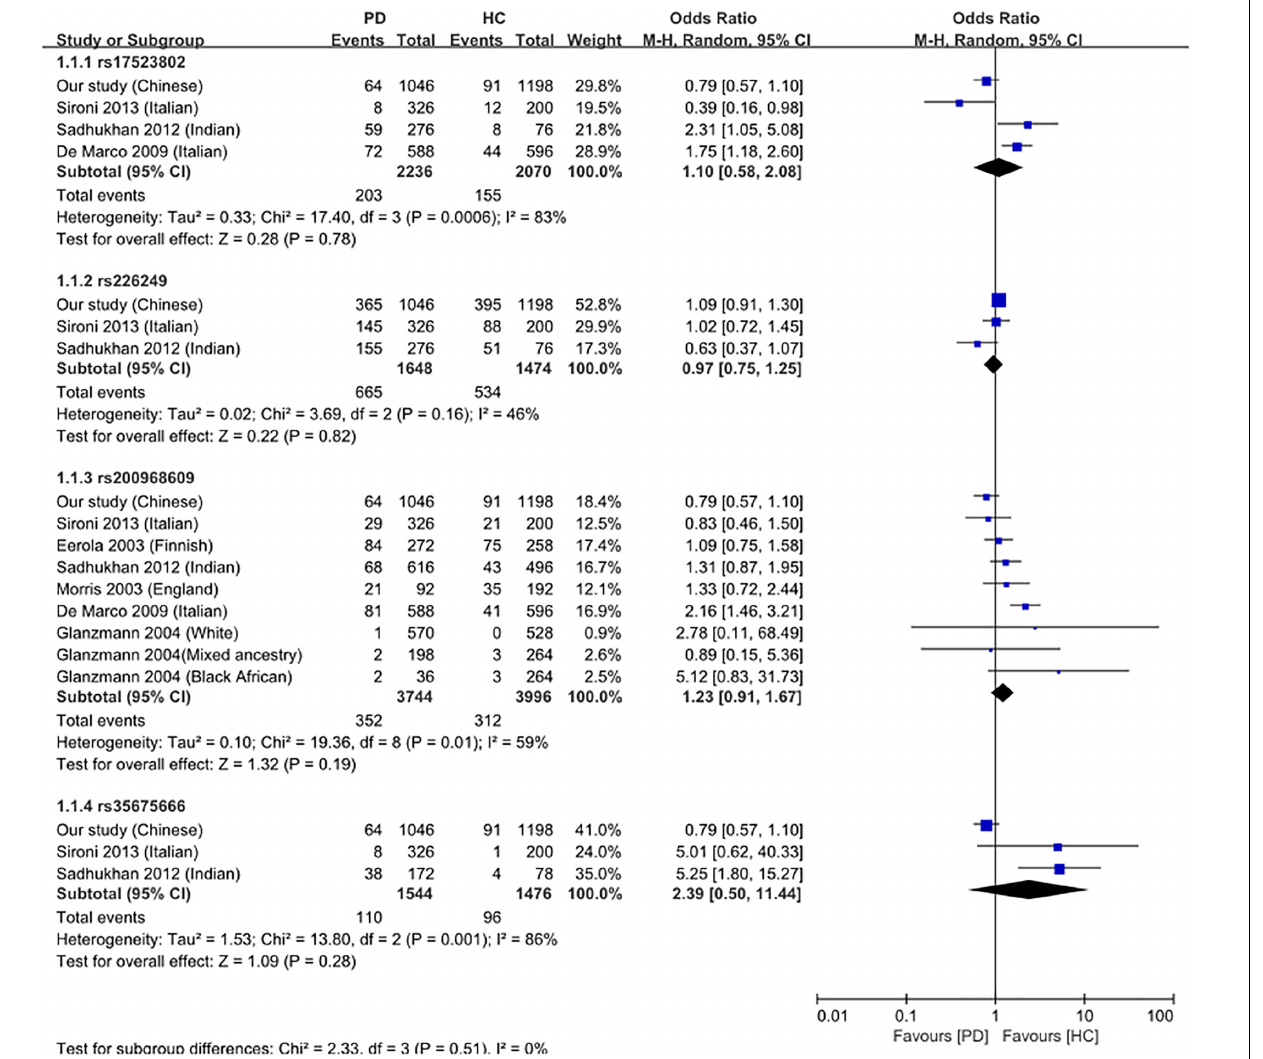
FIGURE 2 | Forest plots of the meta-analysis between DJ-1 promoter polymorphisms and PD under the allelic model. For meta-analysis, rs17523902 p = 0.777, rs226249 p = 0.816, rs200968609 p = 0.188, and rs35675666 p = 0.276. OR, odds ratio; CI, confidence interval; I-squared,